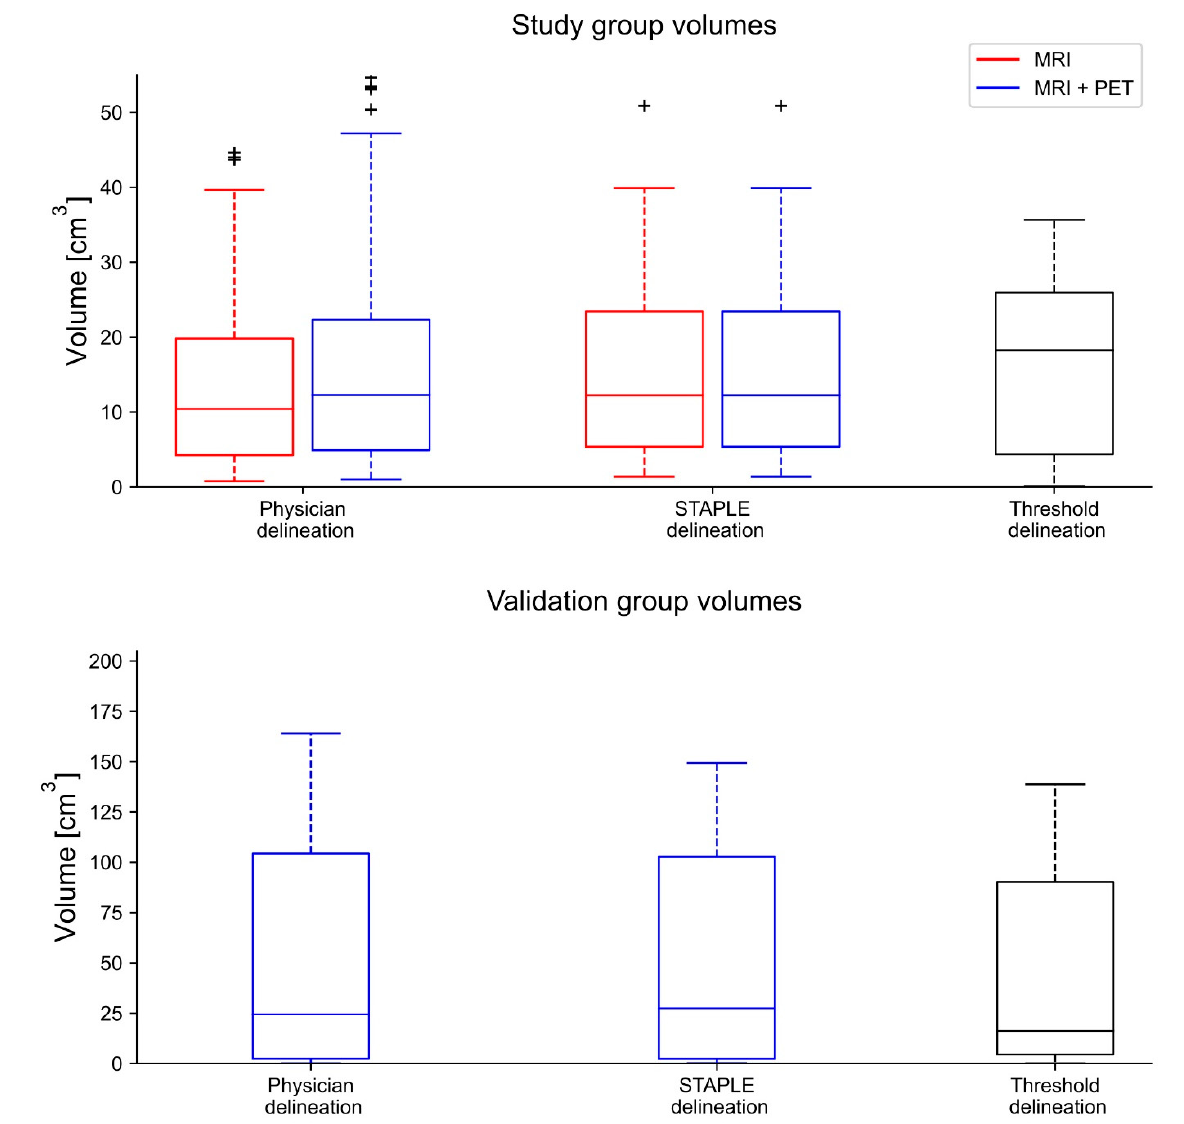
Figure 2. In this boxplot, the volume of each delineation method is displayed. Compared to the MRI delineations of the physicians, the MRI + PET delineations are on average bigger. The biggest volumetric outlier is found in the MRI delineation (not displayed here).